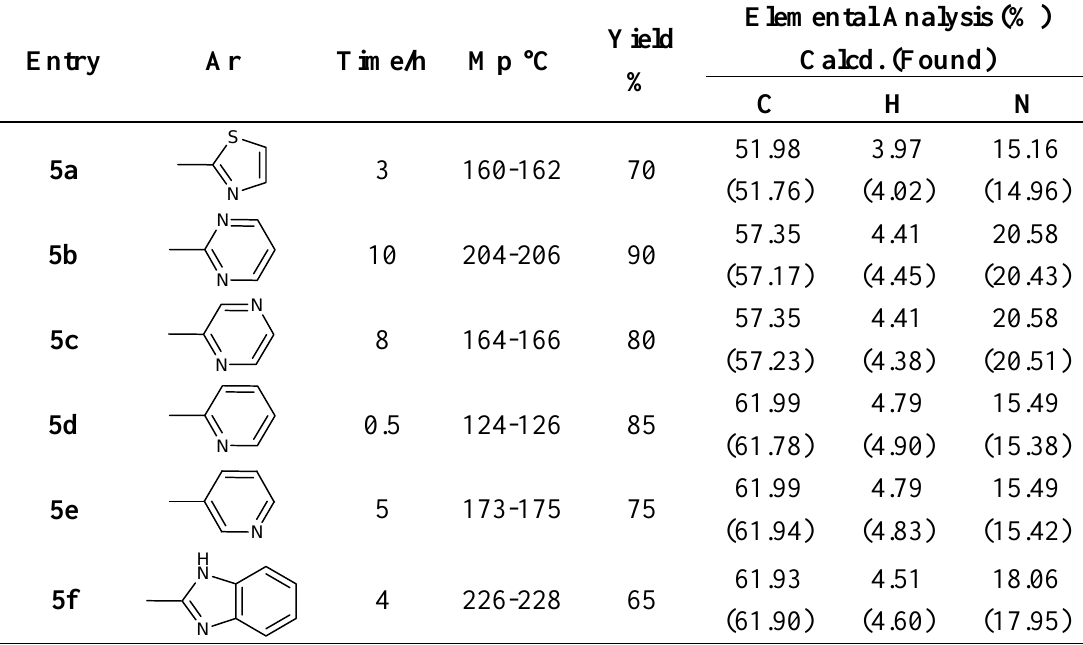
Table 1 . Yields, melting points and elemental analyses of compounds 5a-f